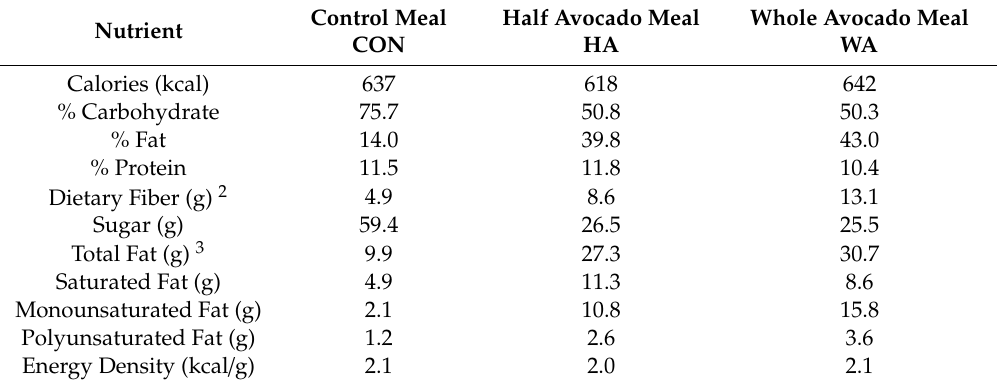
Table 1. Nutrient composition of breakfast test meals for postprandial study day visits 1